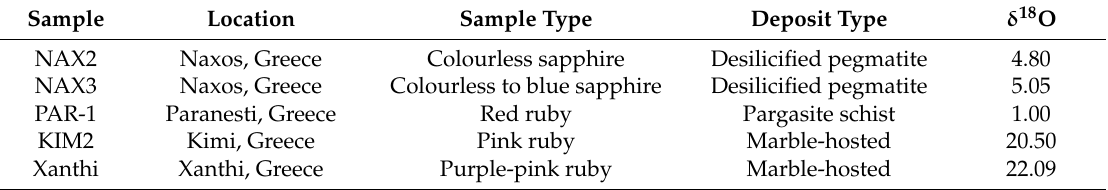
Table 3. Oxygen isotope results from the 2009 reconnaissance using the laser-fluorination method, n =